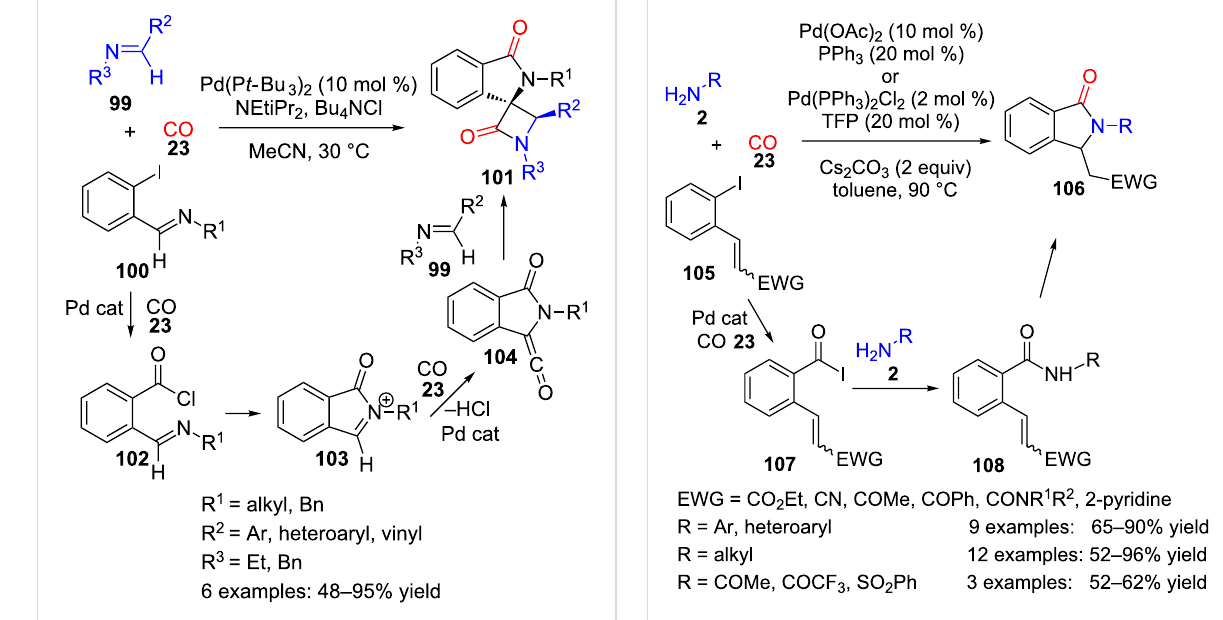
99 that would give rise to the spiro β - and γ -lactam